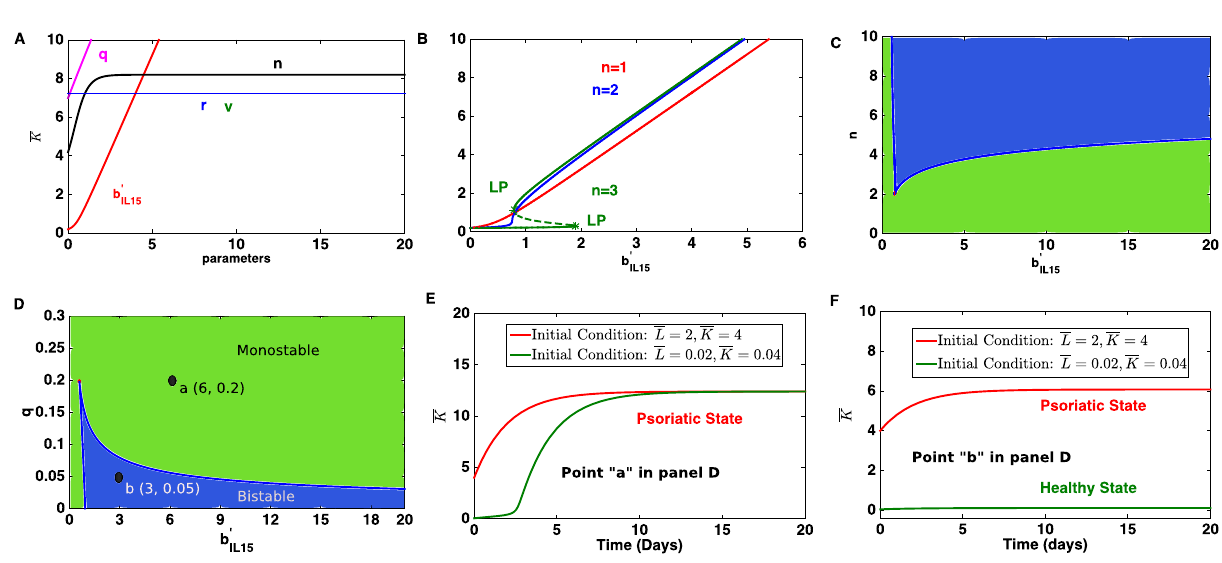
Figure 5. A signal response curve for the subnetwork involving cytokine IL-15 (Fig. 1D). ( A ) Changes in the stead state population of keratinocytes in response to changes in the model parameters. ( B ) The hyper- proliferation of keratinocytes can occur via a bistable regime in response to varying level of IL-15. In that regime the steady state keratinocyte population can exist in two distinct states: low and high. The low steady state population corresponds to a healthy population and the higher one corresponds to a psoriatic state. ( C ) The separation of bistable (blue) and monostable (green) regions in the two parameter spaces formed by the level of IL-15 and Hill coefficient (n). ( D – F ) A demonstration of typical trajectories of the keratinocyte population in monostable and bistable regions. While the point “a” is in monostable region, the point “b” lies in the bistable ′ = 4, v = 0.1, r = 0.01, q = 0.1, n = 1, µ L = 0.5 and µ K = 0.5 . The region. The model parameters are: b IL − 15 initial condition is ¯ L = 2 and ¯ K = 4